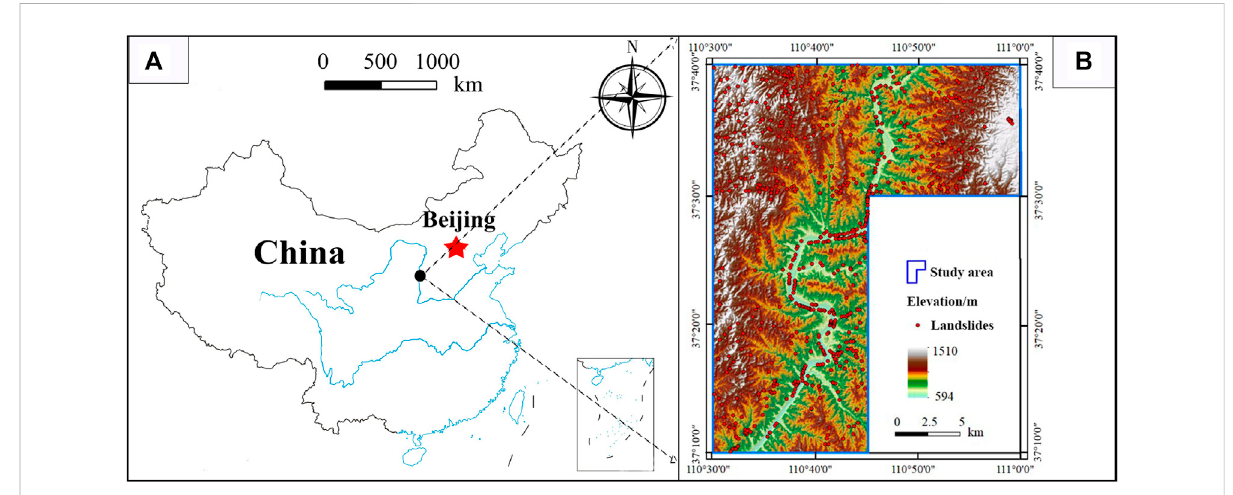
FIGURE 1 (A) Locationofthestudyarea,wherethetwobluelinesrepresentthetwobiggestriversinChina,namelytheYangtzeRiverandtheYellowRiver, whereas the blue boundary shows the coastline of China; (B) Spatial distribution of the landslides in the study area, and the digital elevation mode is used as the base